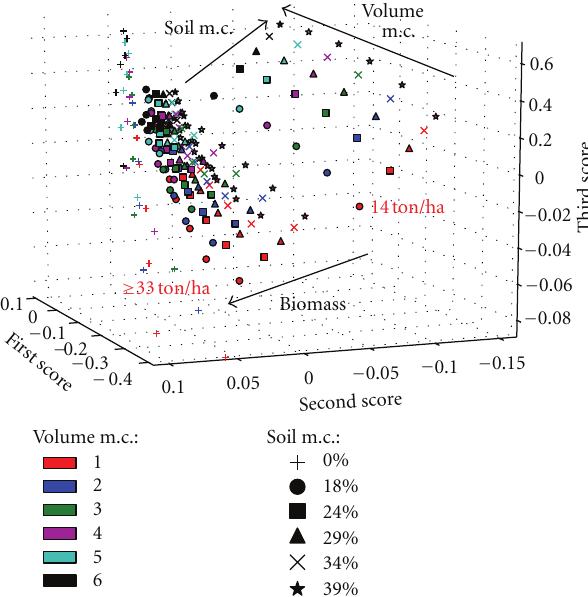
Figure 10: Result of a PCA on radar HH, HV, and VV radiometry. In the 3D representation of the 3 third vectors, the color corre- sponds to the volume m.c. and the symbol to the soil m.c. The corresponding biomass from 14 to 133ton/ha is indicated in the